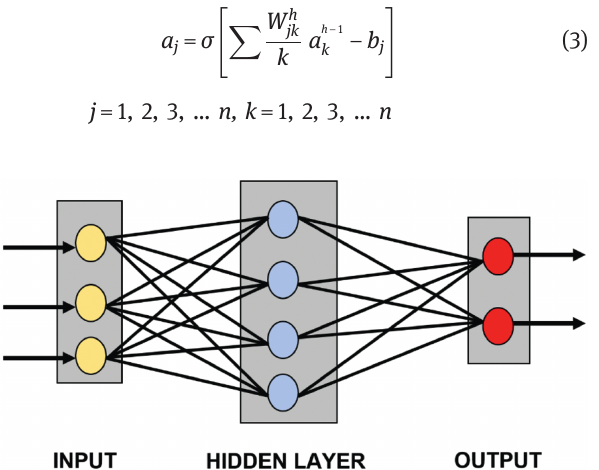
Figure 5: BPNN model used for parameter analysis and